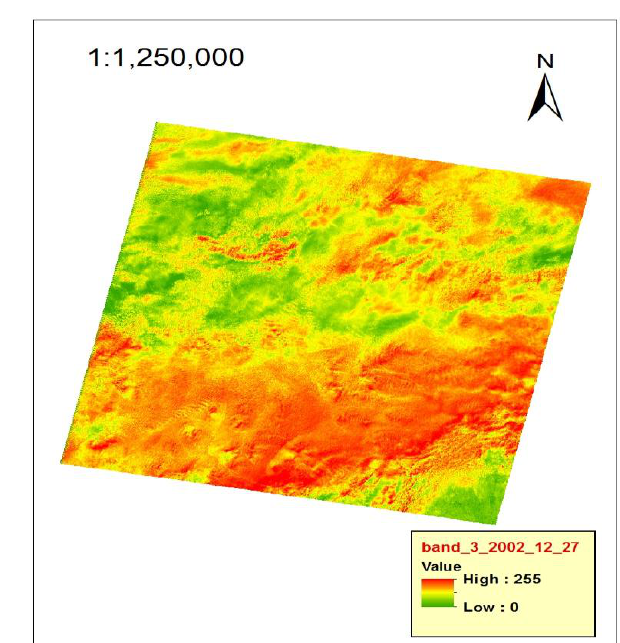
Fig.3: Show image classification of band (3) for study area in date (27/12/2002).